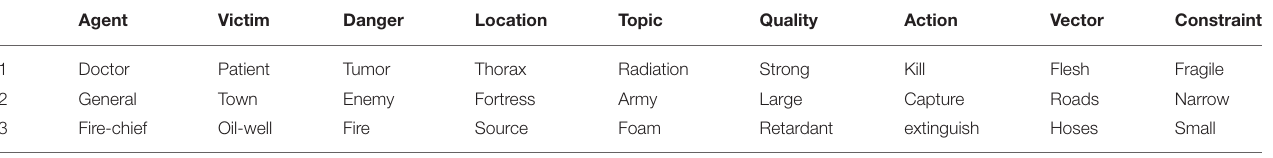
TABLE 4 | Mapping of arguments in the three convergence problems onto the convergence schema narrative